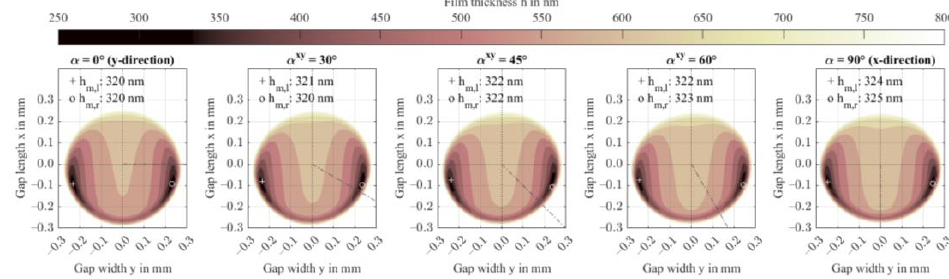
Figure 11. Film thickness contours including minima for variation of the fiber orientation 𝛼 𝑥𝑦 in the xy-plane, as indicated by the dashed line.